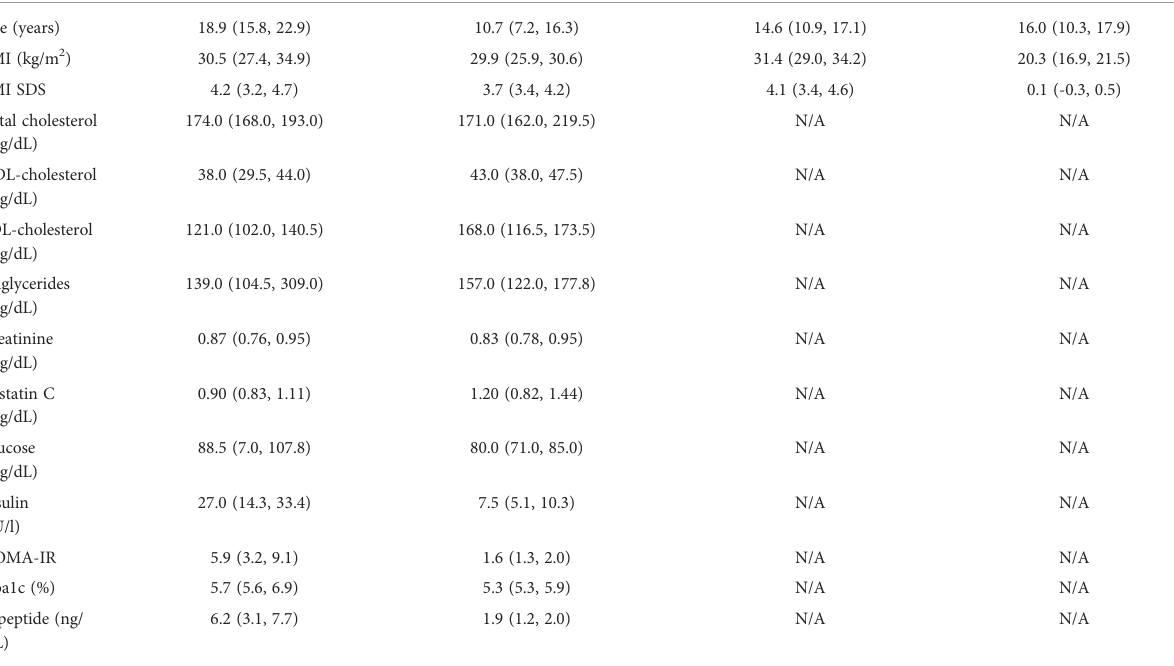
TABLE 1 Clinical characteristics of the patients from the study